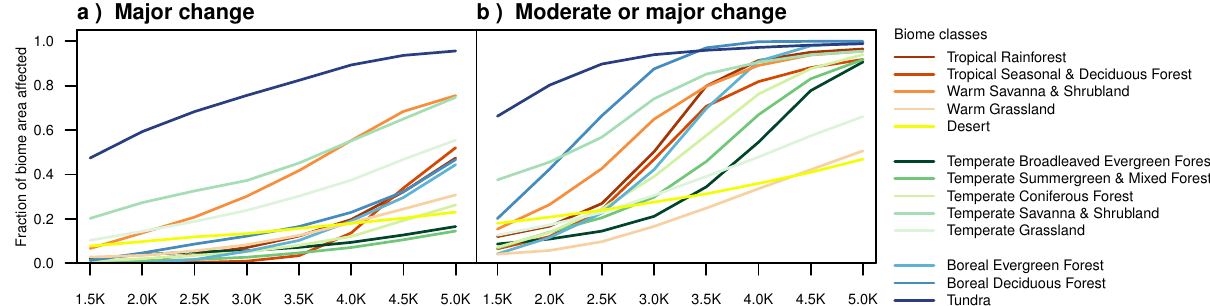
Fig. 3. Biome area affected by (a) major ( 0 > 0.3) or (b) at least moderate ( 0 > 0.1) ecosystem change by around 2100 with at least medium confidence ( ≥ 10/19 AOGCMs in agreement). For other levels of confidence, see Fig. S6 in the